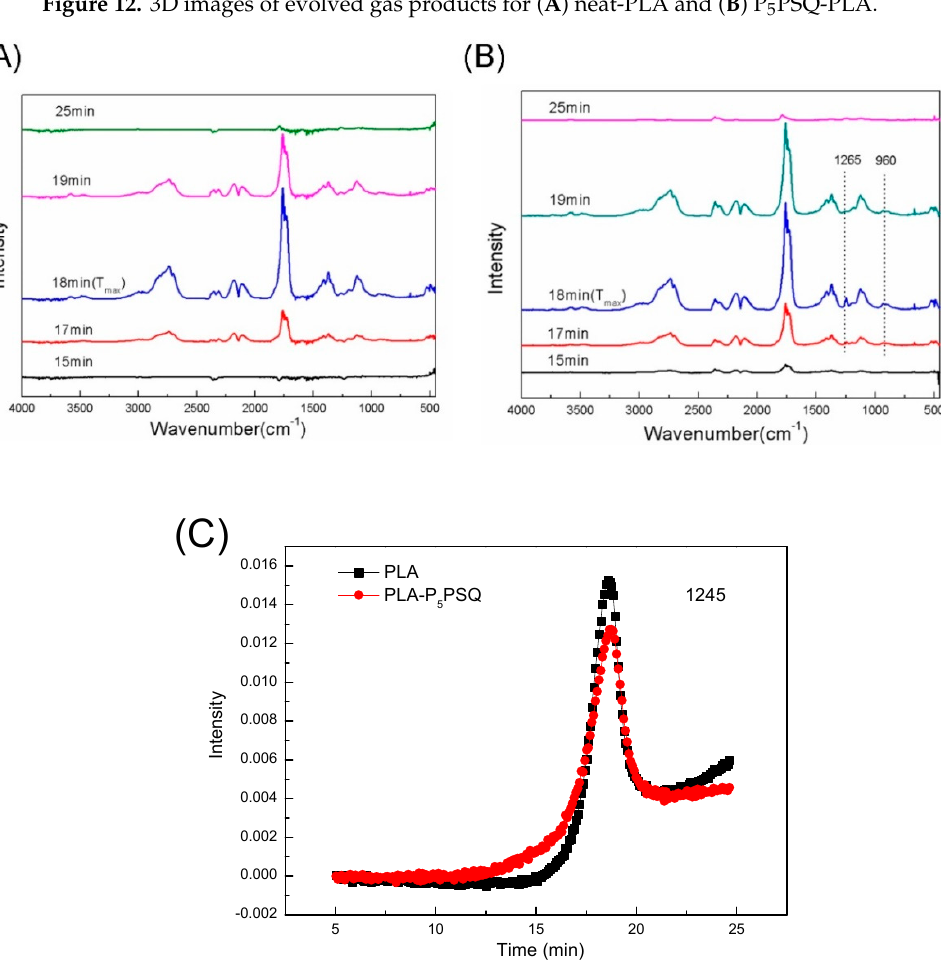
Figure 13. FT-IR spectra of pyrolysis products for ( A ) i-PLA, ( B ) P 5 PSQ-PLA at different times and the product curves at 1245 cm -1 vs time for neat-PLA and P 5 PSQ-PLA ( C ).